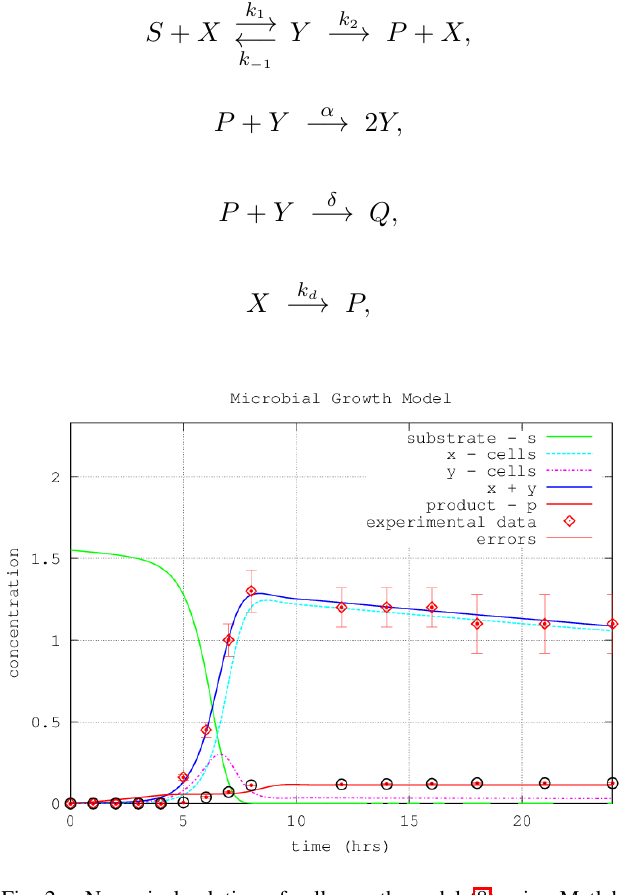
Fig. 2. Numerical solution of cell growth model (8) using